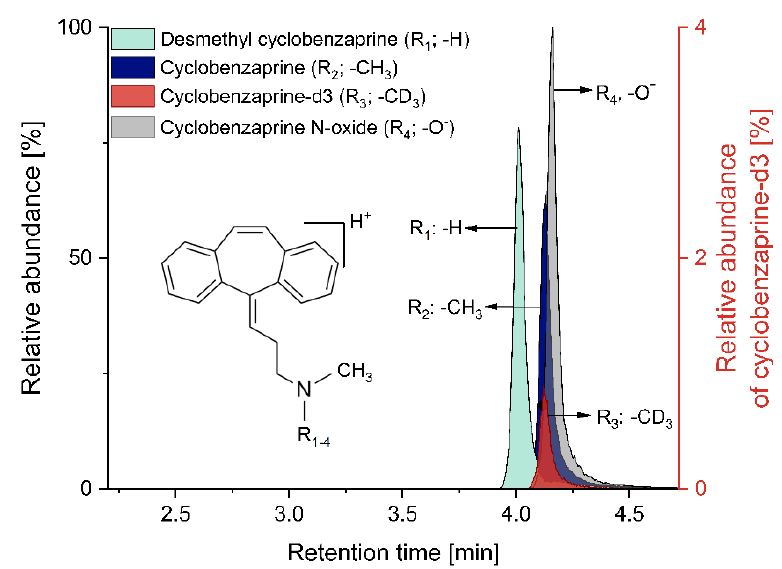
Figure 1. LC-MS/MS chromatogram of desmethyl cyclobenzaprine, cyclobenzaprine, cyclobenzaprine-d3 and cyclobenzaprine N-oxide with the respective structural formula. Table 3. Summary of accuracy and precision results for cyclobenzaprine, desmethyl cyclobenzaprine and cyclobenzaprine N-oxide (accuracy presented as mean relative error and precision as coefficient of variation, n = 5 per run). CV, coefficient of variation; LLOQ, Lower limit of quantification; QC, quality control.